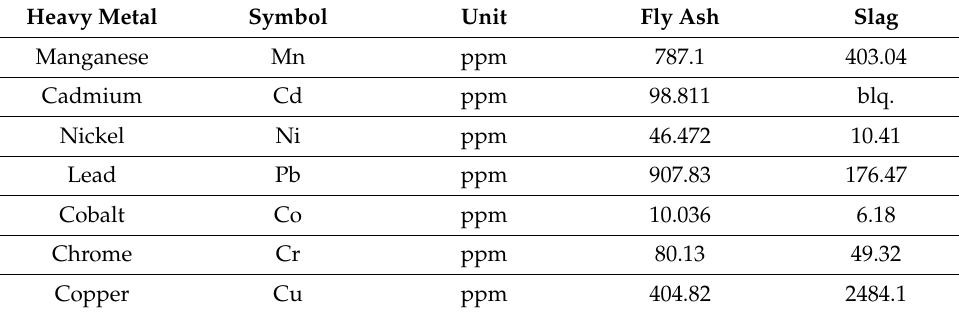
Table 2. Content of heavy metals in fly ash. Heavy